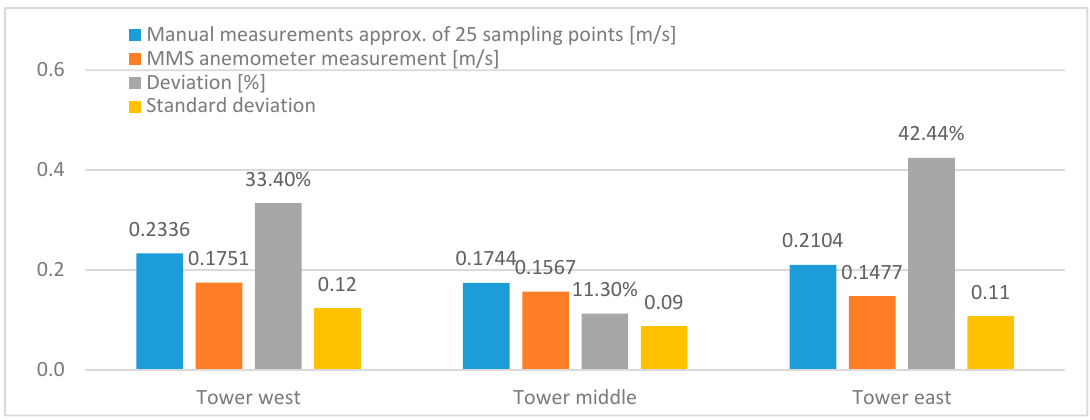
Figure 13. Manual measurement results in 25 sampling points per each tower about air velocity in the bottom inlets in 3 m height.